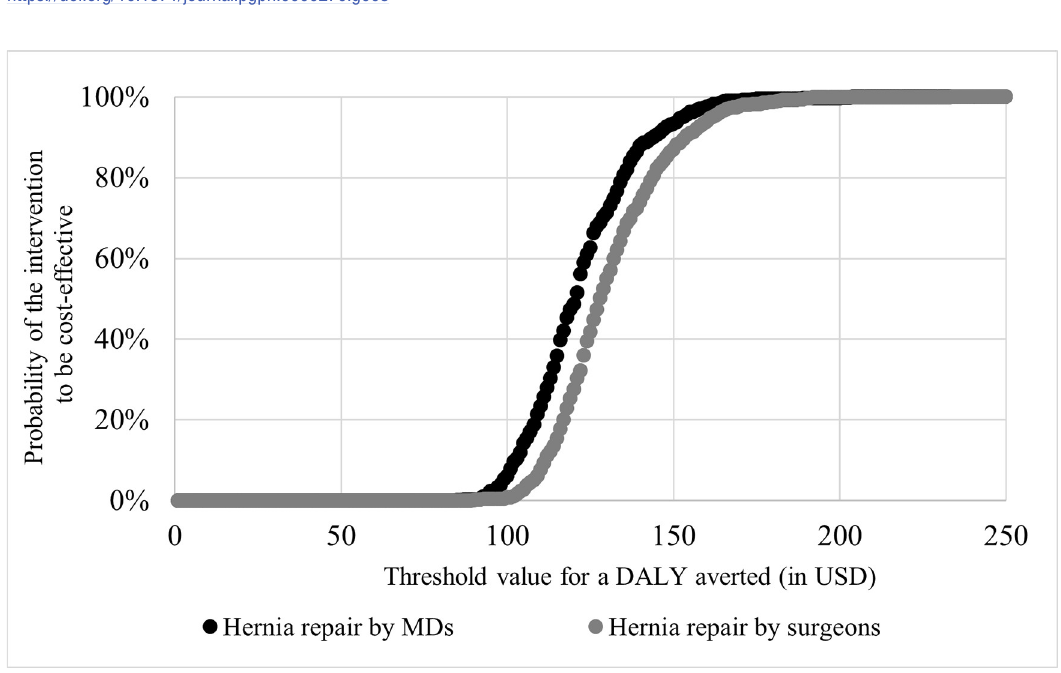
Fig 4. Cost-effectiveness acceptability curve of inguinal hernia repair by different providers in Ghana. MDs medical doctors; DALY disability-adjusted life year. The line graph displays probability of inguinal hernia repair, by MDs and surgeons, to be cost- effective by different threshold values for a DALY averted (in USD).